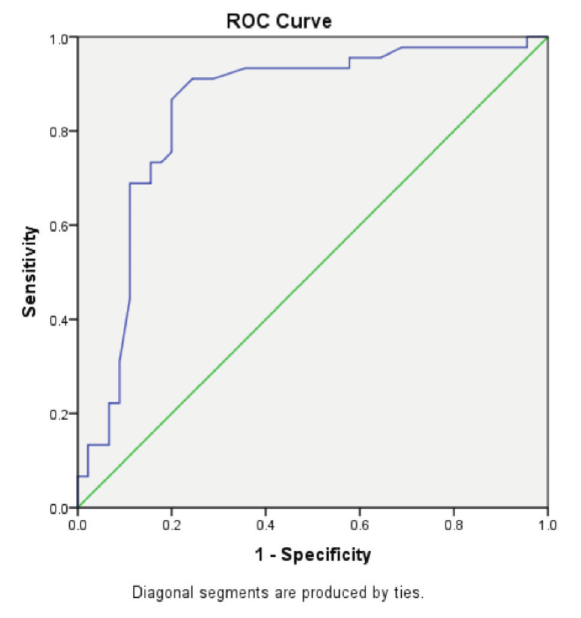
Receiver Operator Characteristic (ROC) curve of Fig. 1: osteoprotegerin of